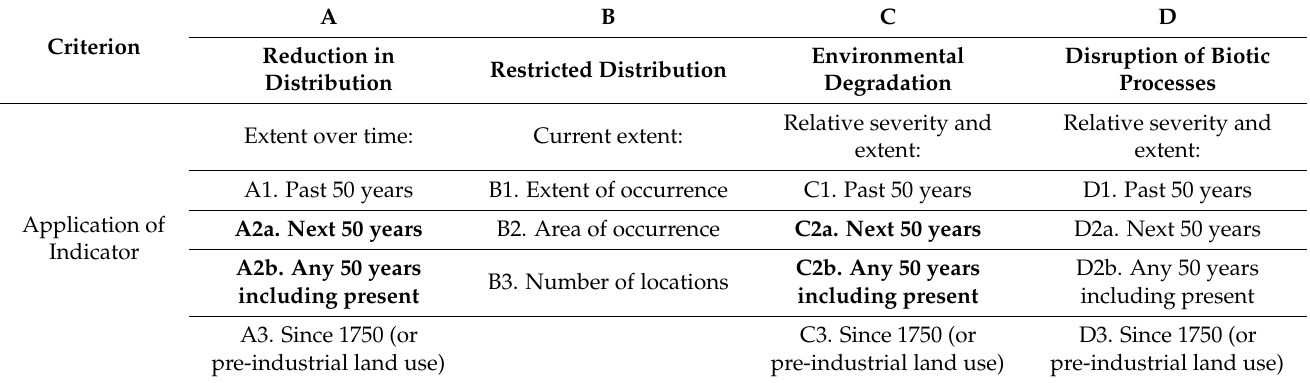
Table 1. Criteria summary for ecosystem red listing using the IUCN framework, with criteria most applicable to climate change effects highlighted in bold [9].